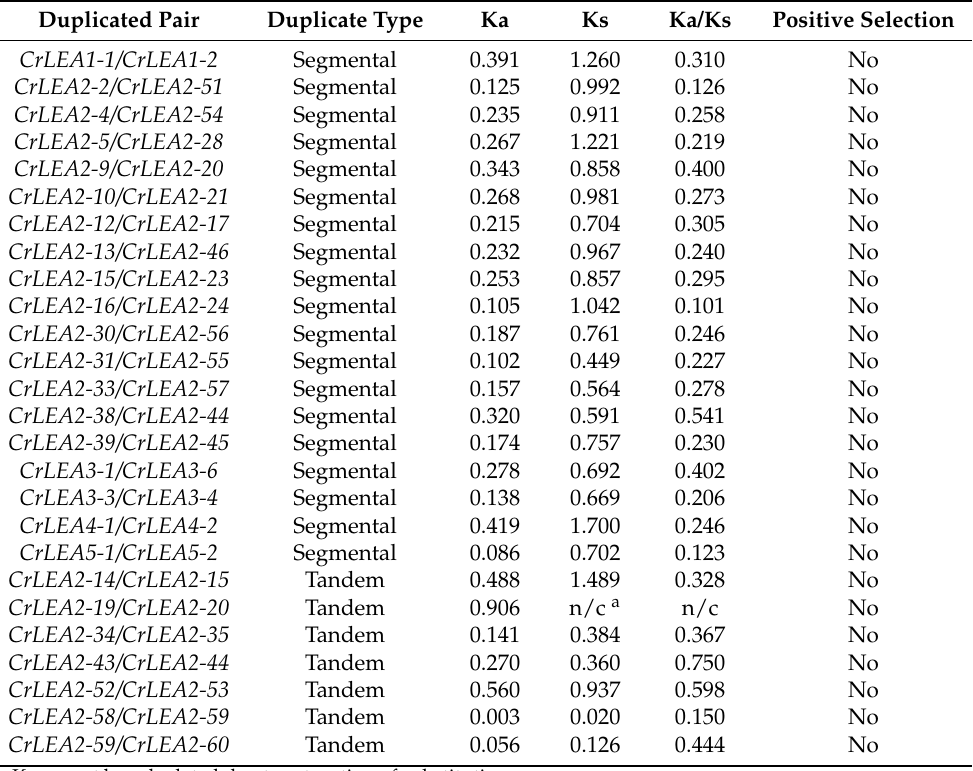
Table 2. Ka/Ks analysis and duplicated date calculation for CrLEA